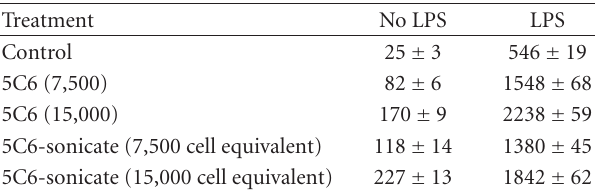
Table 1: HMC-1 5C6 directly and synergistically with LPS enhance endothelial cell production of